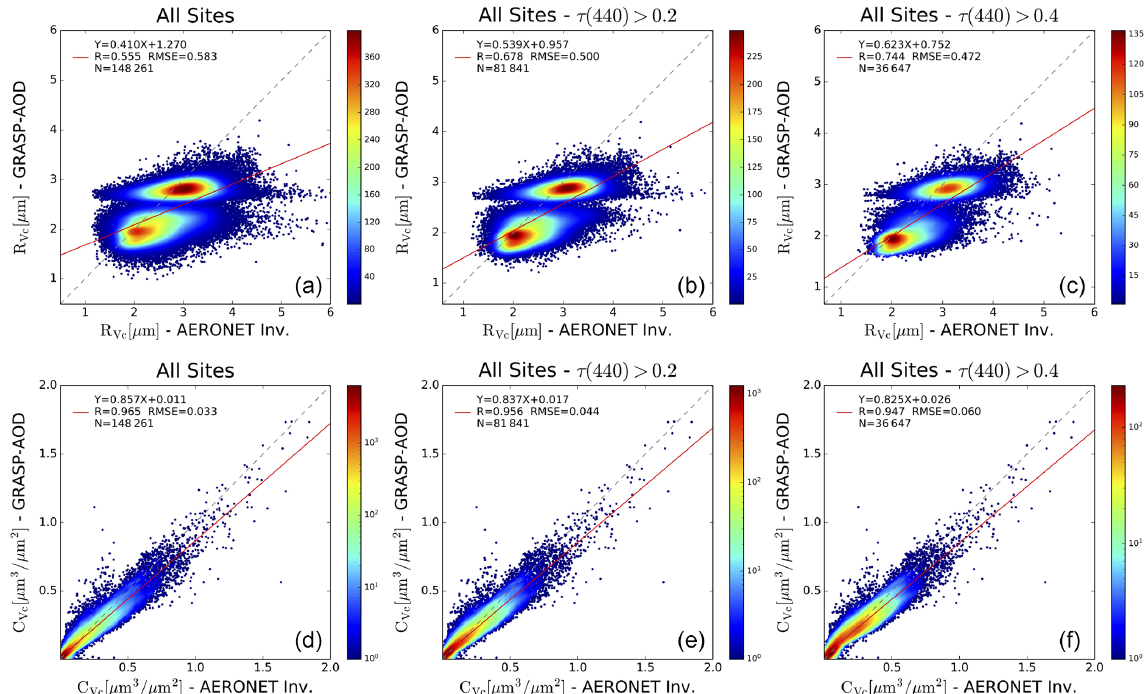
Figure 9. Comparisons between the coarse-mode volume properties obtained by the GRASP-AOD and AERONET aerosol retrieval algo- rithm for all sites considered in the analysis (Table 1) during the period 1997–2016. Comparisons for the coarse-mode volume median radius ( R Vc [µm]) are represented in (a) – (c) , while comparisons for the coarse-mode volume concentration ( C Vc [µm 3 /µm 2 ]) are shown in (d) – (f) . Different thresholds for τ( 440 ) have been applied in the comparisons from (a) to (f) : all the retrievals ( τ( 440 ) > 0 . 02), retrievals with τ( 440 ) > 0 . 2 and retrievals with τ( 440 ) > 0 . 4. Color bars represent data density in a 0 . 05 × 0 . 05µm grid for R Vc and in 0 . 01 × 0 . 01µm 3 /µm 2 grid for C Vc . For the volume concentration, a logarithmic scale has been chosen given the strong data density at low